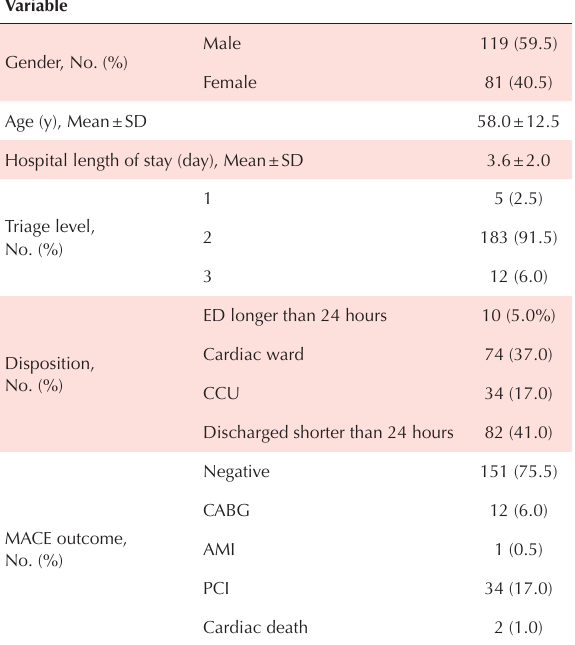
Table 1. Baseline and demographic data